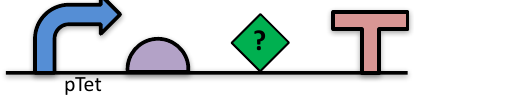
Figure 32: DNA sequence with three primer binding sites.